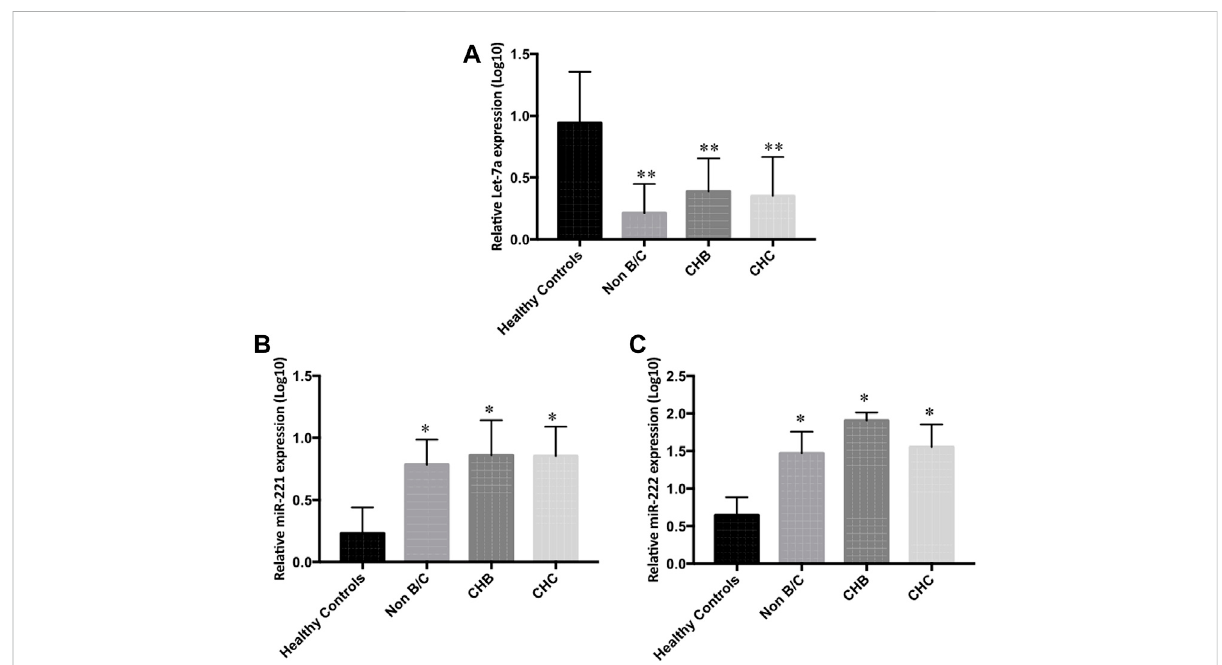
FIGURE 5 Differentialserumexpressionlevelsof (A) Let-7a, (B) miR-221,and (C) miR-222innon-B/C(non-hepatitisBandnon-hepatitisC),CHB(chronic hepatitis B), and CHC (chronic hepatitis C) groups of patients compared to peritumor tissue were measured by rt-qPCR. The statistical analysis was done using Mann – Whitney test (GraphPad Prism 5.0). The statistically signi fi cant p -value was denoted as < 0.05. NS; non-signi fi cant.